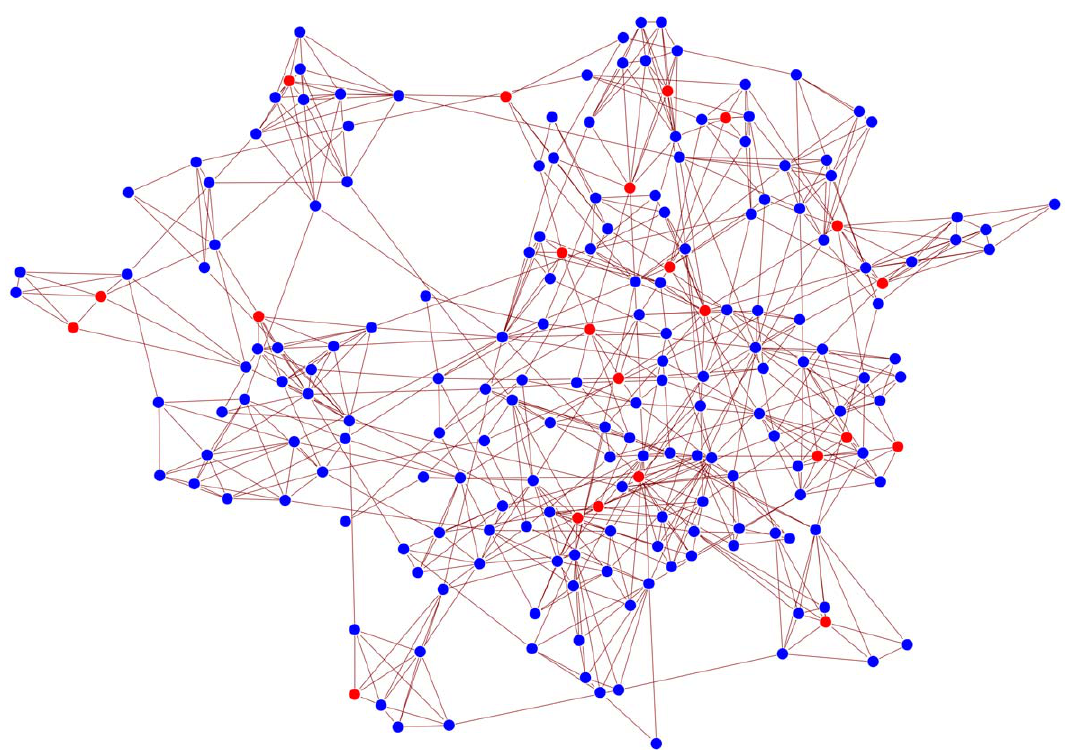
Figure 5. Scabies clustering. Typical example from scenario 1 of a 200-node network at equilibrium showing affected individuals (red disks) in the context of community structure. Note how scabies occurs in clusters.